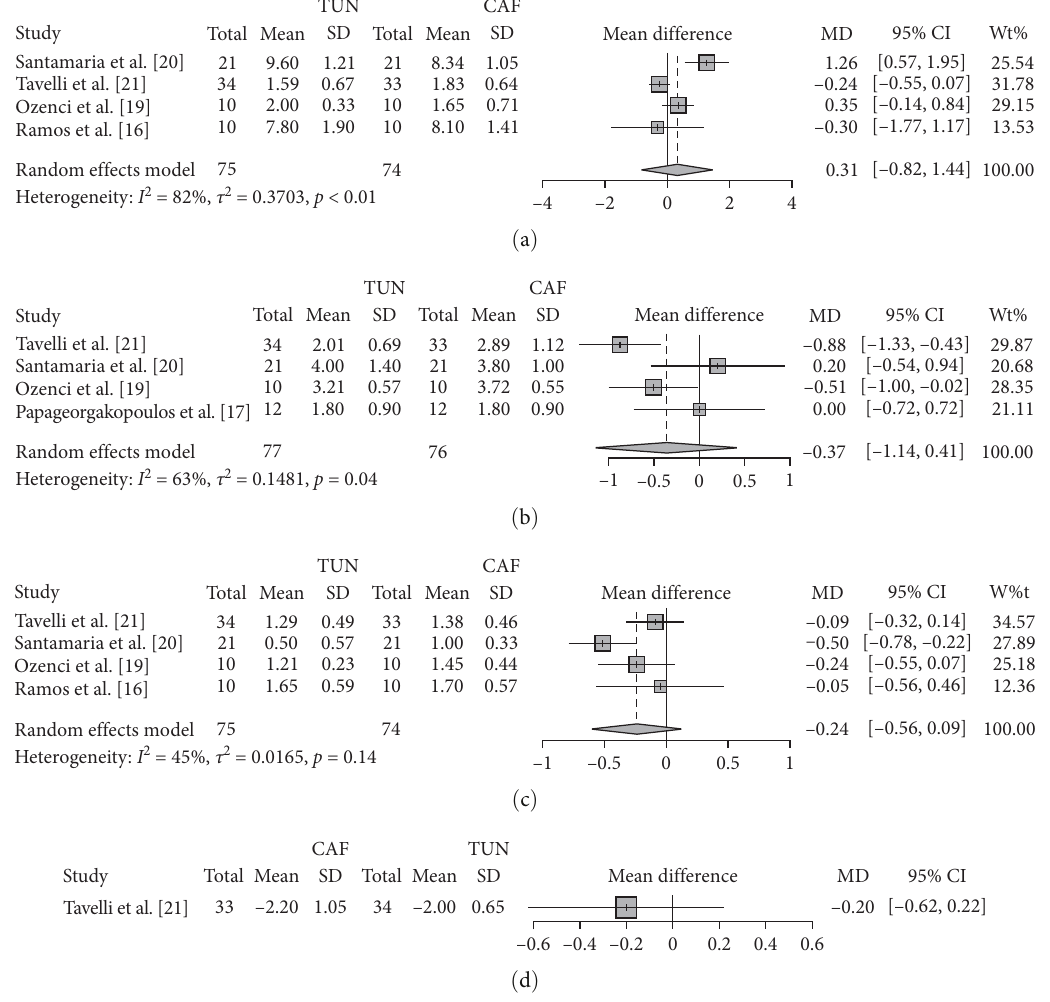
F IGURE 3: Effects of TUN vs. CAF on secondary outcomes: (a) CAL (mm); (b) KTW (mm); (c) PD (mm); (d) REC